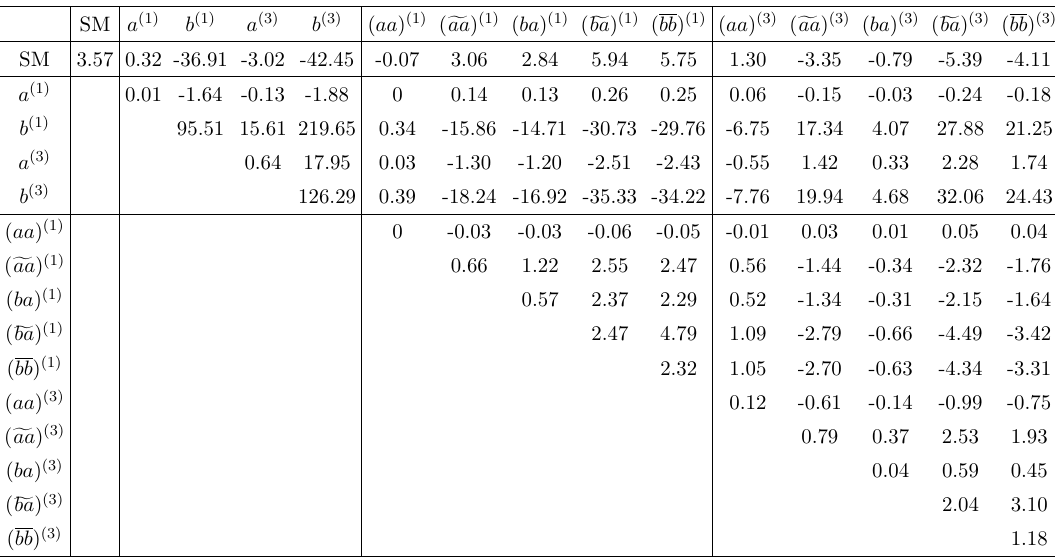
¯ B s → µ + µ − ) × 10 9 . The reference scale is set to